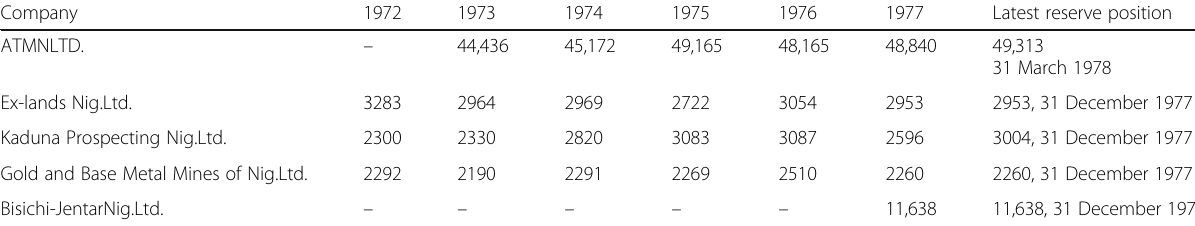
Table 4 Cassiterite reserve in Nigeria from 1972 to 1977 (metric tonnes) Company ATMNLTD. Ex-lands Nig.Ltd. Kaduna Prospecting Nig.Ltd. Gold and Base Metal Mines of Nig.Ltd. Bisichi-JentarNig.Ltd.